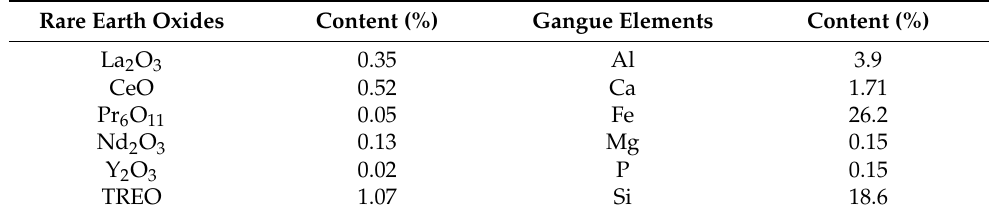
Table 1. Chemical composition of the tailings.